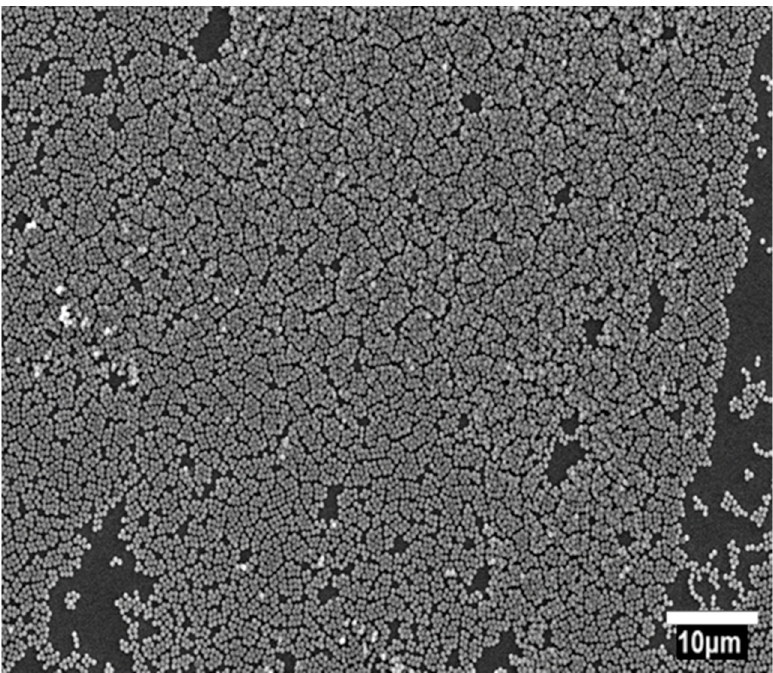
Figure 14. MSNs configuration obtained by spin-coating followed by dipping in sodium dodecyl sulfate (SDS) solution.